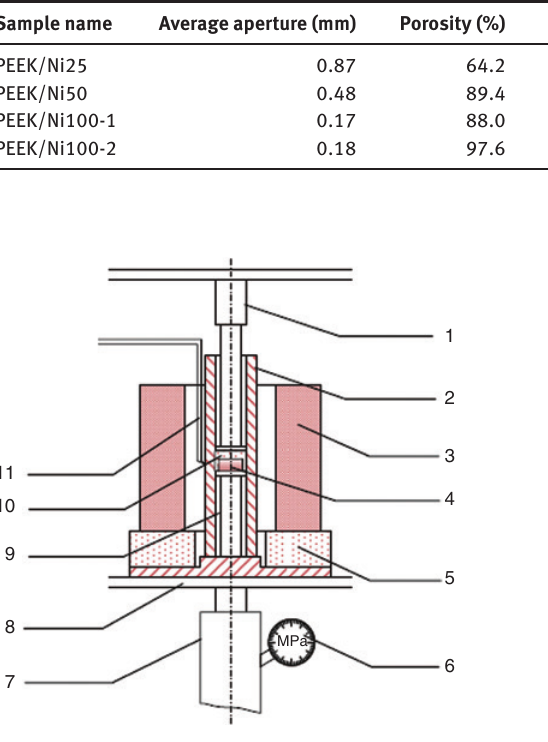
Figure 2: Schematic of the preparation device: (1) upper mold, (2) outer mold, (3) oven, (4) Ni foam, (5) heat-insulating material, (6) gas-pressure meter, (7) jack, (8) base plate, (9) lower mold, (10) PEEK, and (11) thermal